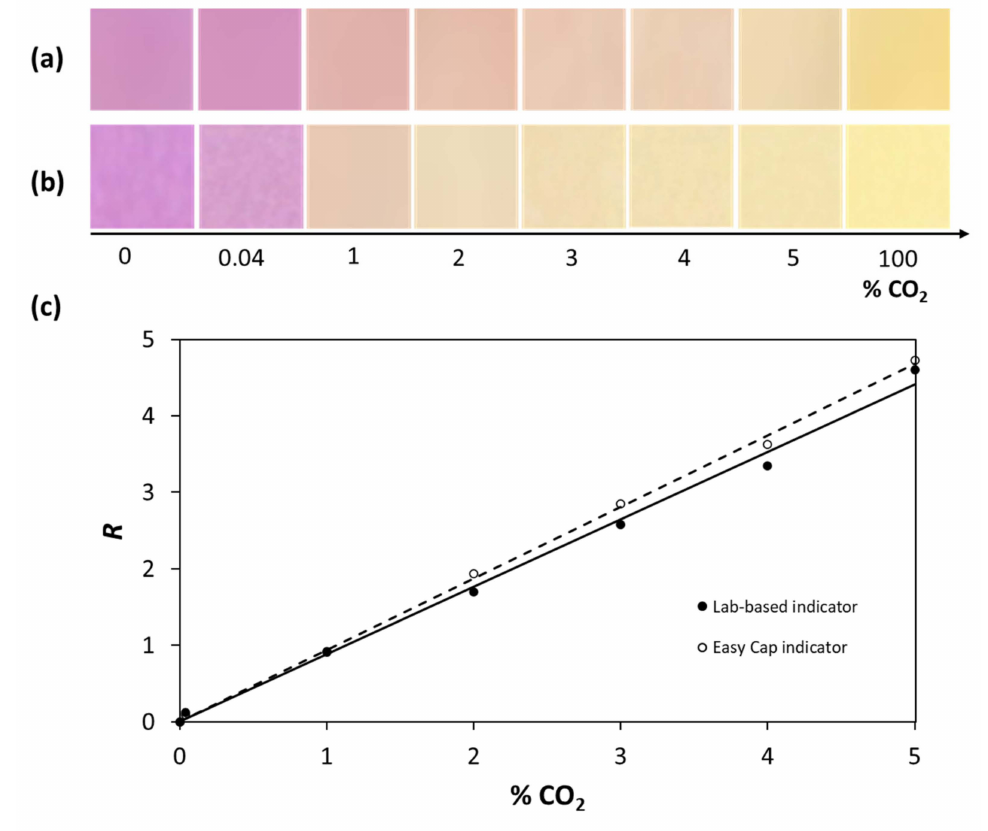
Figure 5. Photographs of ( a ) lab-based drop capnography indicator and ( b ) Easy Cap indicator films when sparged with different CO 2 /Ar gas mixtures. The plots in ( c ) are of R vs. % CO 2 , where the values of R were calculated using Equation (5) and the apparent absorbance values determined from the digital images in ( a , b ). The solid and broken lines are those of best fit to the data for the lab-based capnography indicator (black dots) and Easy Cap (open circles) indicators, respectively; the gradients of the lines of best fit, i.e., α in Equation (5), were 0.88 and 0.93% CO 2 − 1 ,